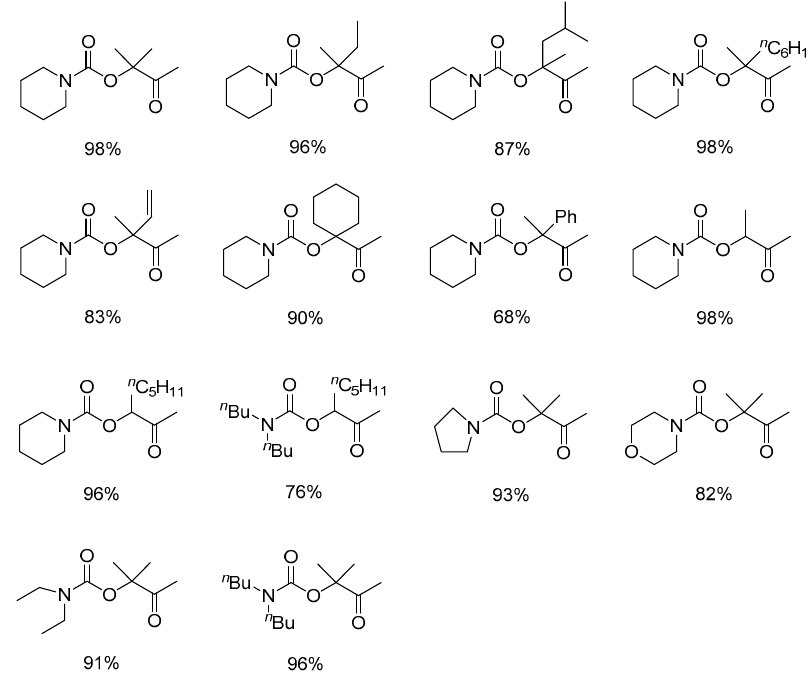
Figure 3. The scope of the [(PPh 3 ) 2 Ag] 2 CO 3 reaction system (isolated yields are given). Reprinted with permission from [32] (Copyright 2014 John Wiley and Sons).